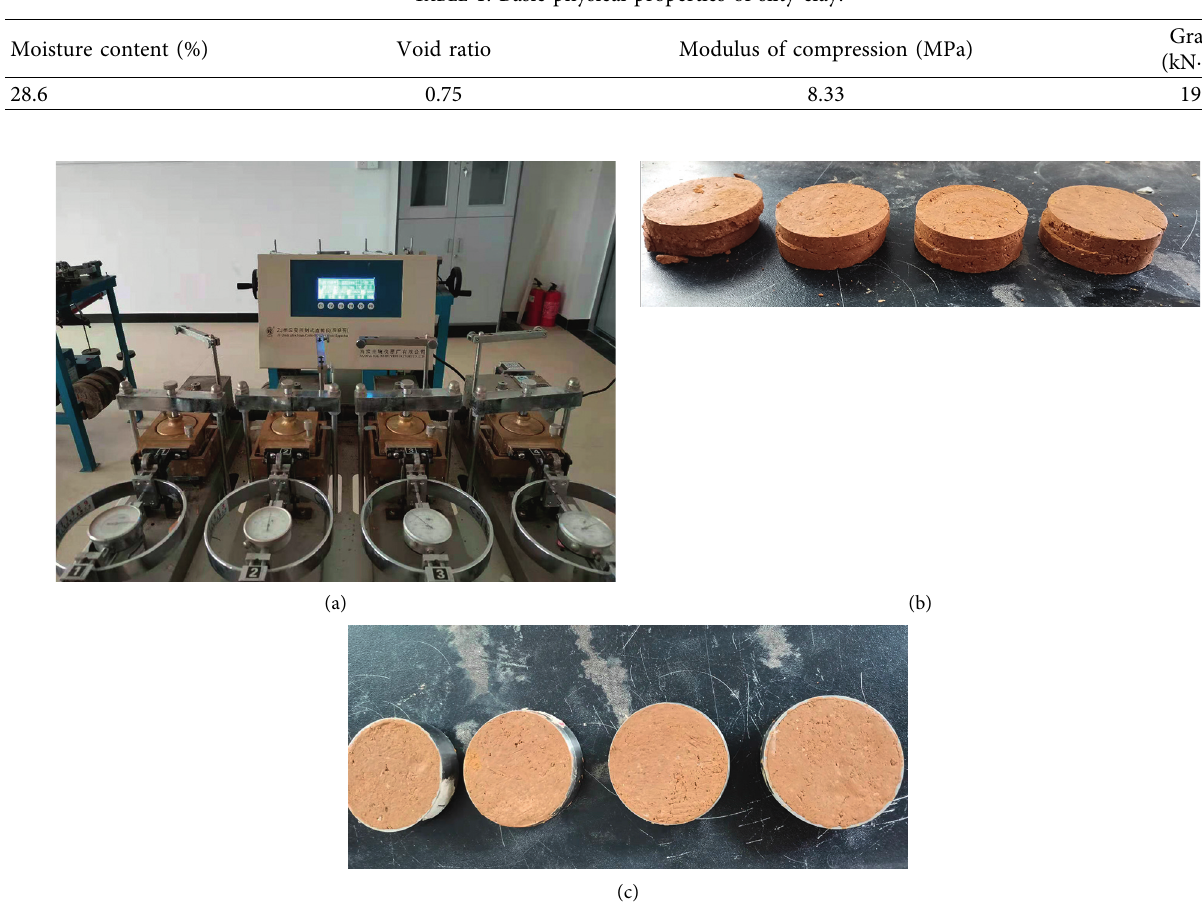
Figure 1: Experimental flow chart. (a) Straight shear. (b) After direct shear test (moisture content 13%). (c) Before direct shear test (moisture content 13%).